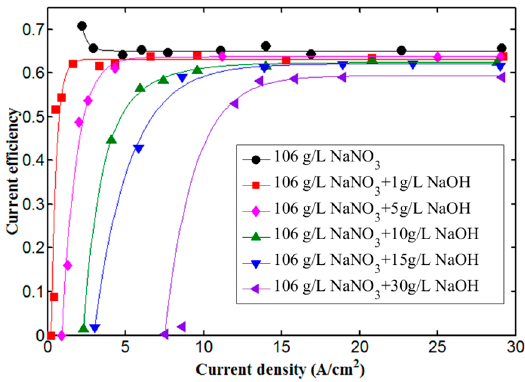
Figure 3. Current efficiency of Inconel 718 dissolution in different electrolyte solutions.